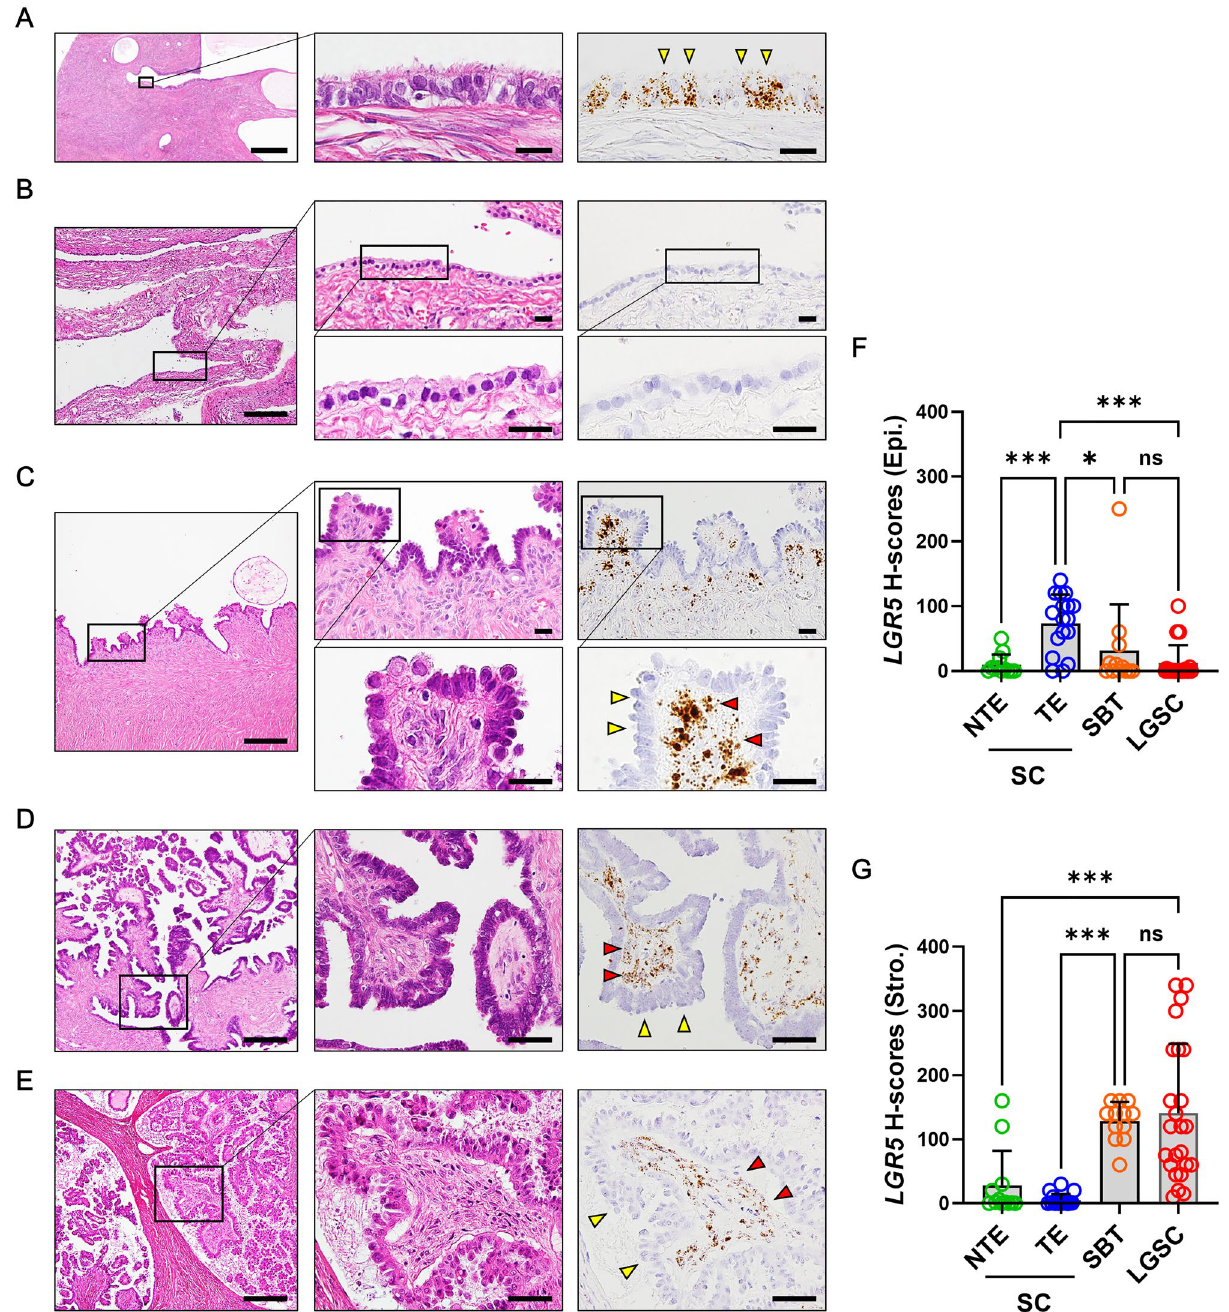
Figure 3. LGR5 expression in serous cystadenoma (SC), serous borderline tumor (SBT), and low-grade serous carcinoma (LGSC). SCs are lined by a single layer of columnar, ciliated cells resembling normal tubal type epithelium (TE) or flat, cuboidal nontubal type epithelium (NTE). ( A ) High levels of LGR5 expression are detected in most cases of TE in SCs. Scale bar, 0.5 mm (left panel) and 20 µm (middle and right panels). ( B ) NTE in SCs mostly exhibits little or no LGR5 expression. Scale bar, 0.2 mm (left panel) and 20 µm (middle and right panels). ( C ) In an SC with focal papillary tufting, subepithelial stromal cells express high levels of LGR5 , whereas nontubal epithelial cells exhibit no LGR5 expression. Scale bar, 0.2 mm (left panel) and 20 µm (middle and right panels). Strong stromal LGR5 expression was observed in most SBTs ( D ) and LGSCs ( E ). Scale bar, 0.2 mm (left panel) and 50 µm (middle and right panels). Bar graphs showing the histo-scores (H-scores) of LGR5 in epithelial tumor cells ( F ) and stromal cells ( G ) in SC (n = 16, spots = 29), SBT (n = 7, spots = 14), and LGSC (n = 9, spots = 18). Yellow arrowheads indicate epithelial tumor cells, and red arrowheads indicate stromal cells. The data are shown as means ± SD. ns not significant. ** P < 0.01, **** P < 0.0001 by Tukey’s multiple comparisons